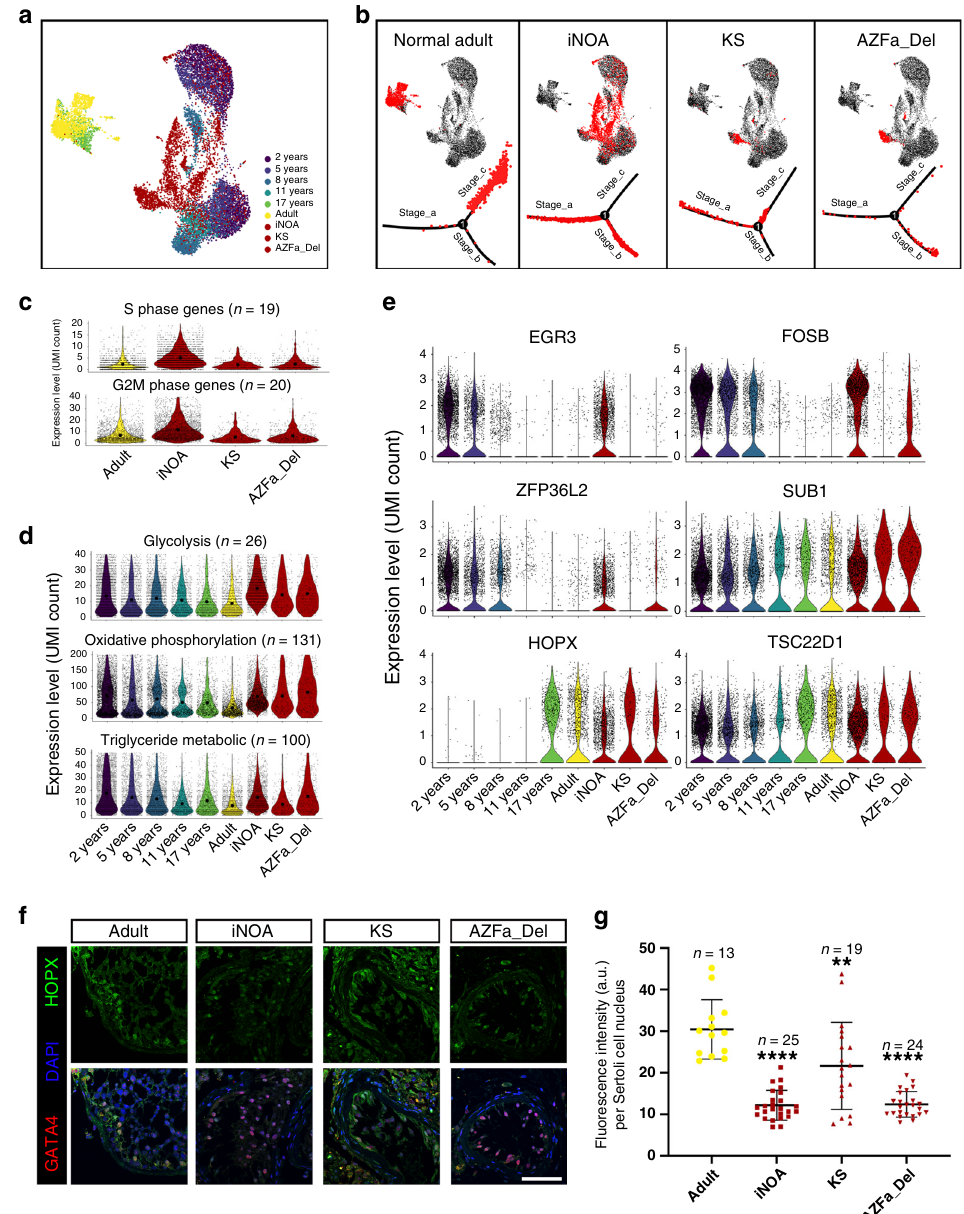
Fig. 4 Single-cell transcriptome pro fi ling of three types of NOA Sertoli cells. a Analysis of normal Sertoli cells at six ages merged with iNOA, AZFa_Del, and KS Sertoli cells, in a UMAP plot with cells colored by age and sample type. b Healthy adult, iNOA, AZFa_Del, and KS Sertoli cells are highlighted red in the UMAP plot (upper row) and the pseudotime trajectory plot (lower row). c Violin plot of the expression levels of S phase and G2M phase-speci fi c genes in healthy adults and three types of pathological Sertoli cells. The larger black dots in each violin plot column represent the mean value. d Violin plot of the expression levels of energy metabolism-related genes in healthy (six different ages) and three types of NOA Sertoli cells. The larger black dots in each violin plot column represent the mean value. e Violin plot of the expression levels of stage-speci fi c master regulators in healthy (six different ages) and three types of NOA Sertoli cells. f , g Immuno fl uorescence co-staining of GATA4 (red) and HOPX (green) in normal adult and three types of pathological testicular paraf fi n sections ( f ). The statistics of nucleoplasm located HOPX expression is shown as histogram ( g ). The fl uorescence intensity per Sertoli cell in adult testis was signi fi cantly higher than iNOA ( p = 7.32E − 05), KS ( p = 0.0077) and AZFa_Del ( p = 8.21E − 05).The scale bar represents 50 μ m. Data shown as mean ± SD, statistical analysis between fl uorescence intensity per Sertoli cell in normal adult and three types of NOA testis made by two-tailed, unpaired non-parametric test with Mann – Whitney test; the con fi dence interval is 95%. ** p < 0.01, **** p < 0.0001 (comparing with normal explained by genetic abnormalities of sex chromosomes or thickening and a higher proportion of interstitial cells were also otherwise. Therefore, we further investigated the iNOA Sertoli observed, but these were not as severe as in KS (Supplementary cells, and focusing on the heterogeneity of maturation, the pro- liferation ability, and their regulatory network. PAS staining of testicular biopsies of all 3 iNOA patients revealed typical SCOS with Johnsen scores of 2; vascular basement membrane